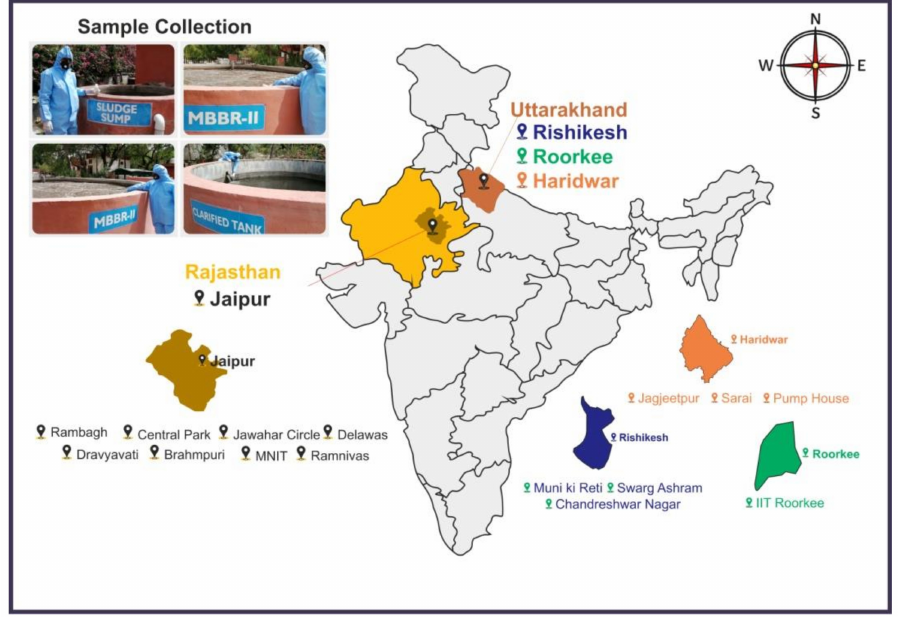
Figure 1. Locations of samples collected from the Uttarakhand and Rajasthan states of